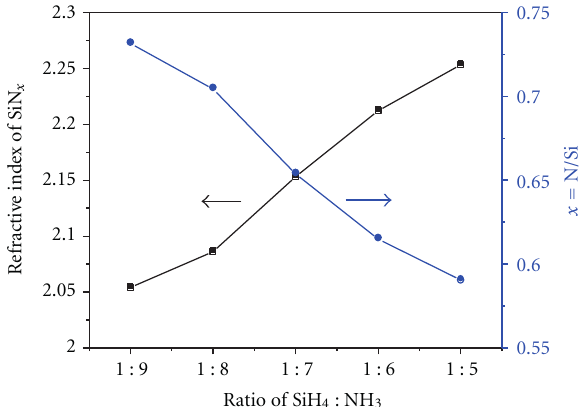
Figure 3: The refractive index and stoichiometry of SiN x varying with the ratio of SiH 4 : NH 3